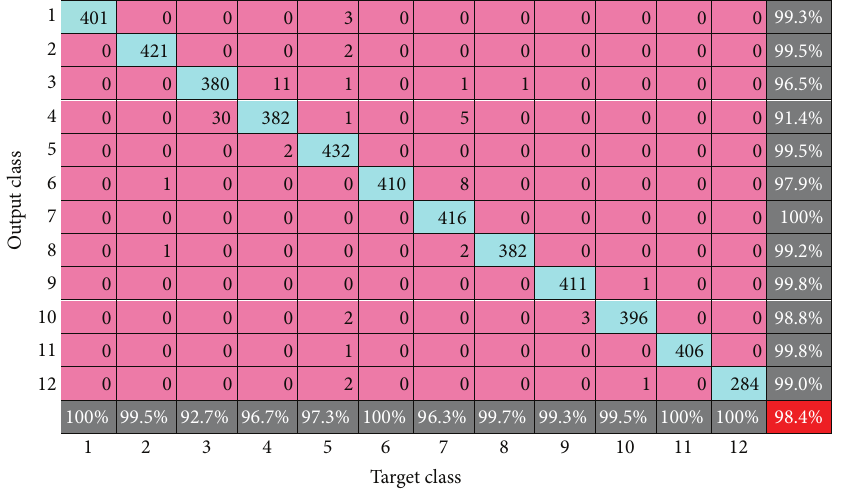
Figure 7: Confusion matrix using CNN.